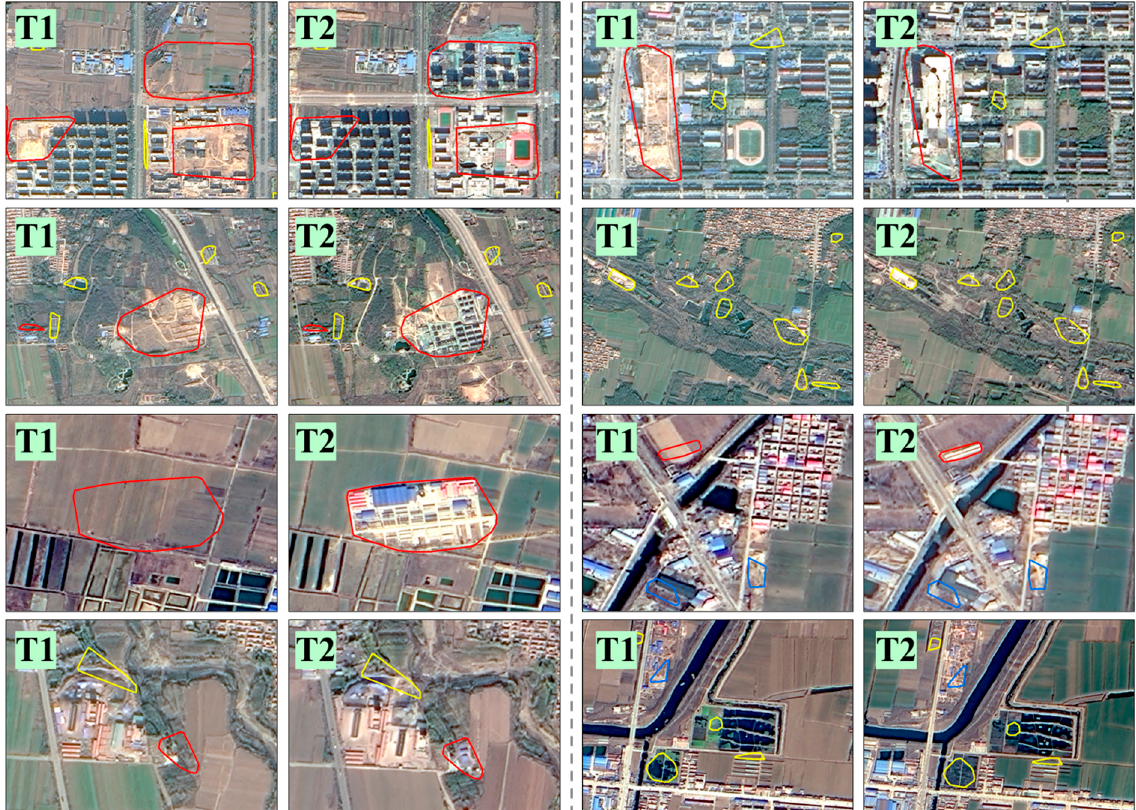
Figure 9. The detection and classification results of NCBAs shown in bi-temporal images ( T1 ) and ( T2 ). Areas surrounded by red, yellow, and blue polygons indicate classification of high, medium, and low confidence.